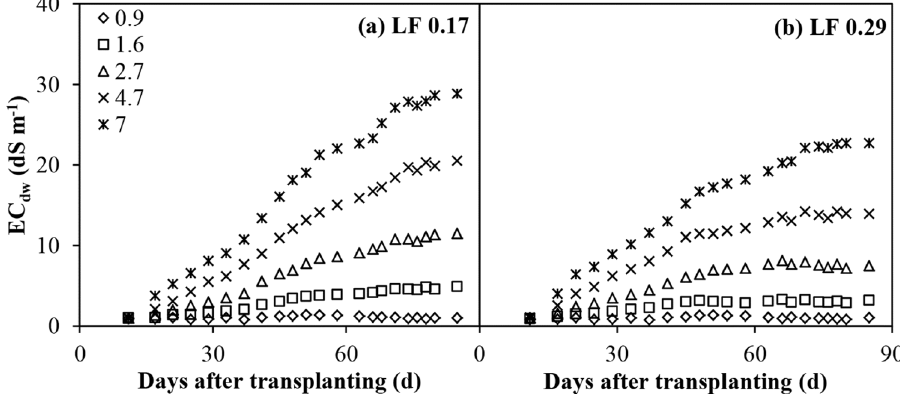
Figure 1. Electrical conductivity of drainage water leaving root zone (EC dw ) as a function of time and irrigation water salinity under two leaching fractions